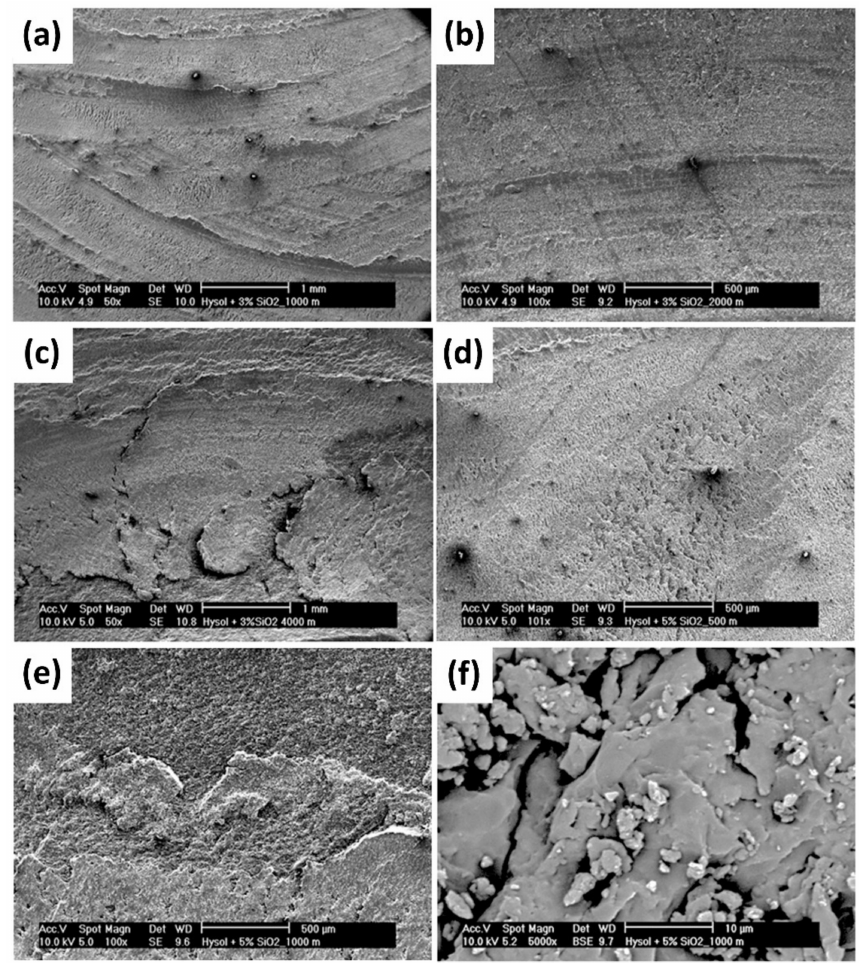
Figure 11. Wear tracks micrographs of 3% SiO 2 nanocomposite at ( a ) 1000 m, ( b ) 2000 m and ( c ) 4000 m, and 5% SiO 2 nanocomposite at ( d ) 500 m, ( e ) 1000 m and ( f ) detailed 1000 m (Reproduced with permission from J. Abenojar, J. Tutor, Y. Ballesteros, J. C. del Real, M. A. Mart í nez,